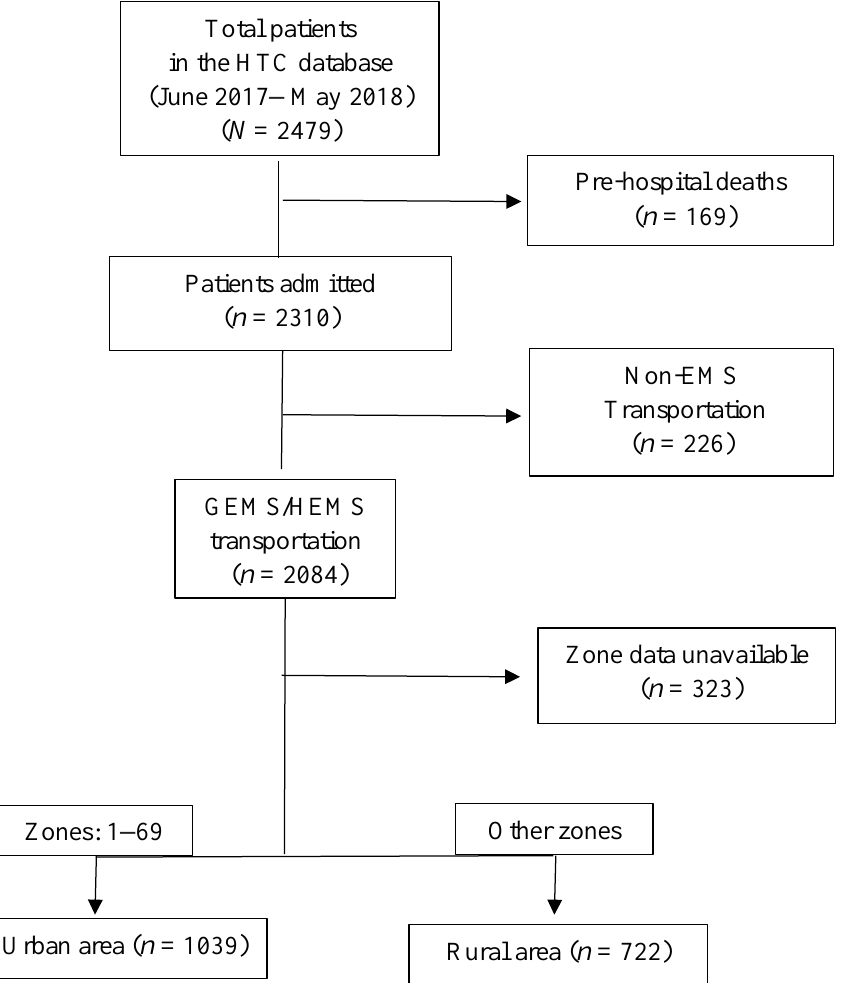
Figure 2. CONSORT (Consolidated Standards of Reporting Trials) flow diagram of emergency medical services (EMS)- transported patients to the Hamad Trauma Center (HMC), Qatar, by urban and rural areas. GEMS: ground EMS; HEMS: helicopter Figure 2: CONSORT flow diagram of EMS transported patients to the Hamad Trauma Center,